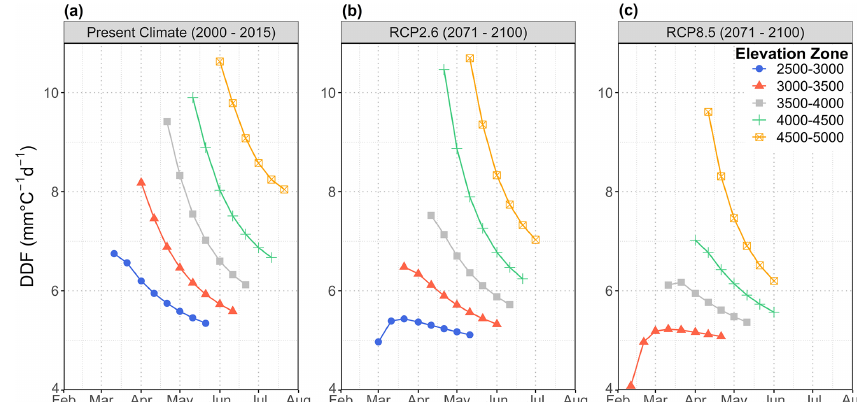
Figure 12. (a) DDF estimates for a temperature-index modelling in the present climate; (b) influence of climate change – 2071–2100 under RCP2.6; (c) influence of climate change – 2071–2100 under